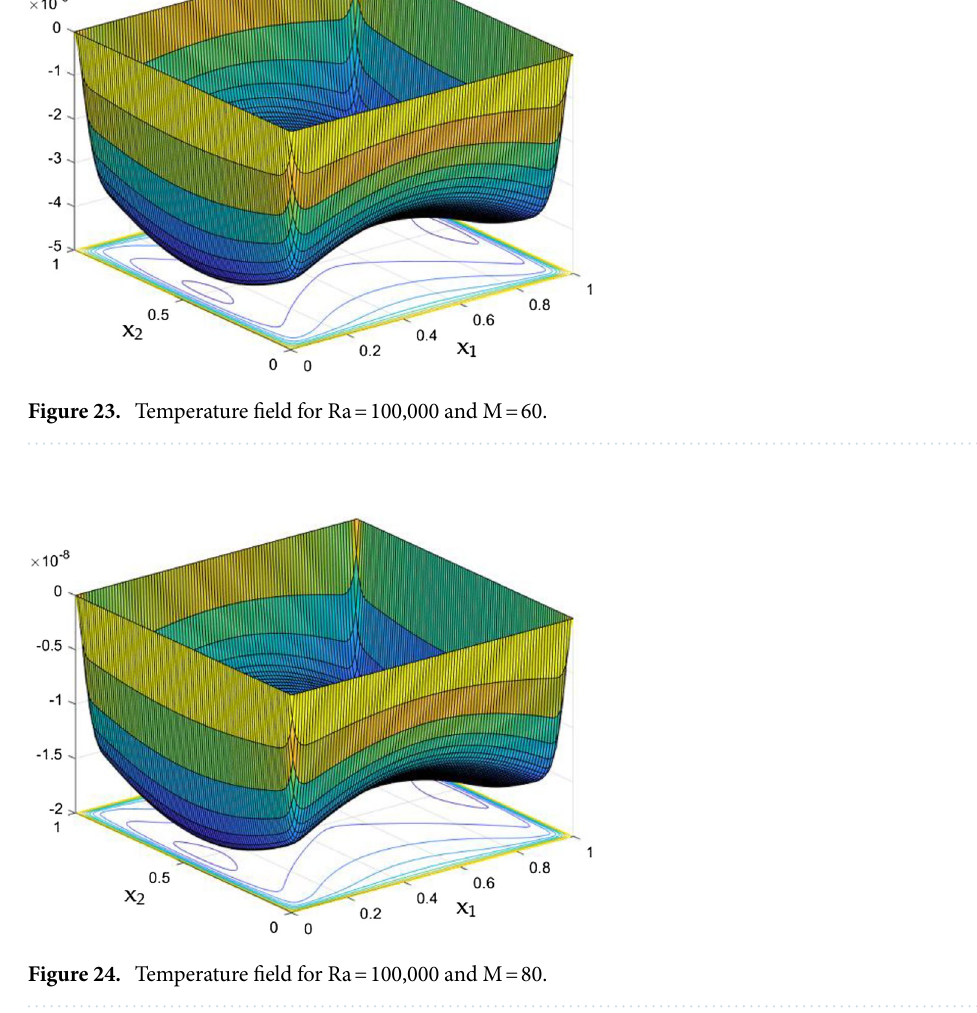
Figure 5 exposes the un interrupted flow nature in the duct in the absence of MF and Rayleigh Number. It clearly shows the smoother flow which were slower near the wall and at the core it moves faster. The prod- uct of the Prandtl number (Pr) and the Grashof number (Gr) can be referred to as the Rayleigh number e. g. Ra = Gr × Pr. It is worth mentioning here that the correlation of viscosity and buoyancy within a fluid is described by the Grashof number. Whereas the Prandtl number expresses the relationship between thermal diffusivity and